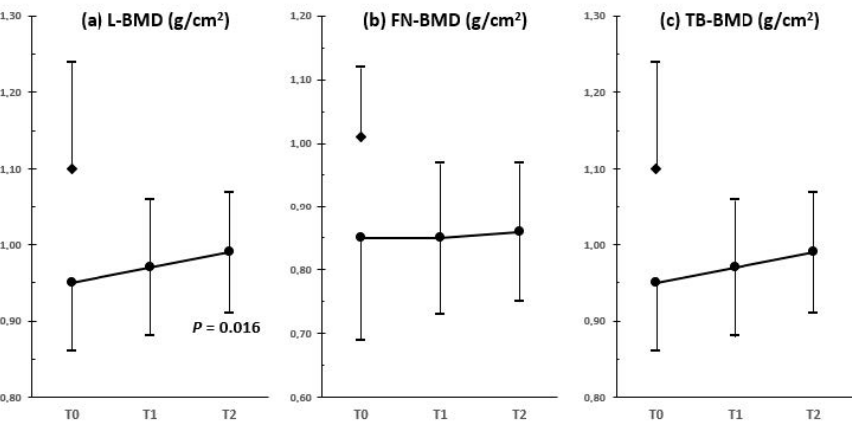
Figure 1. The proband (indicated by the arrow) is a young 46,XY woman (25 years old) with CAIS, in